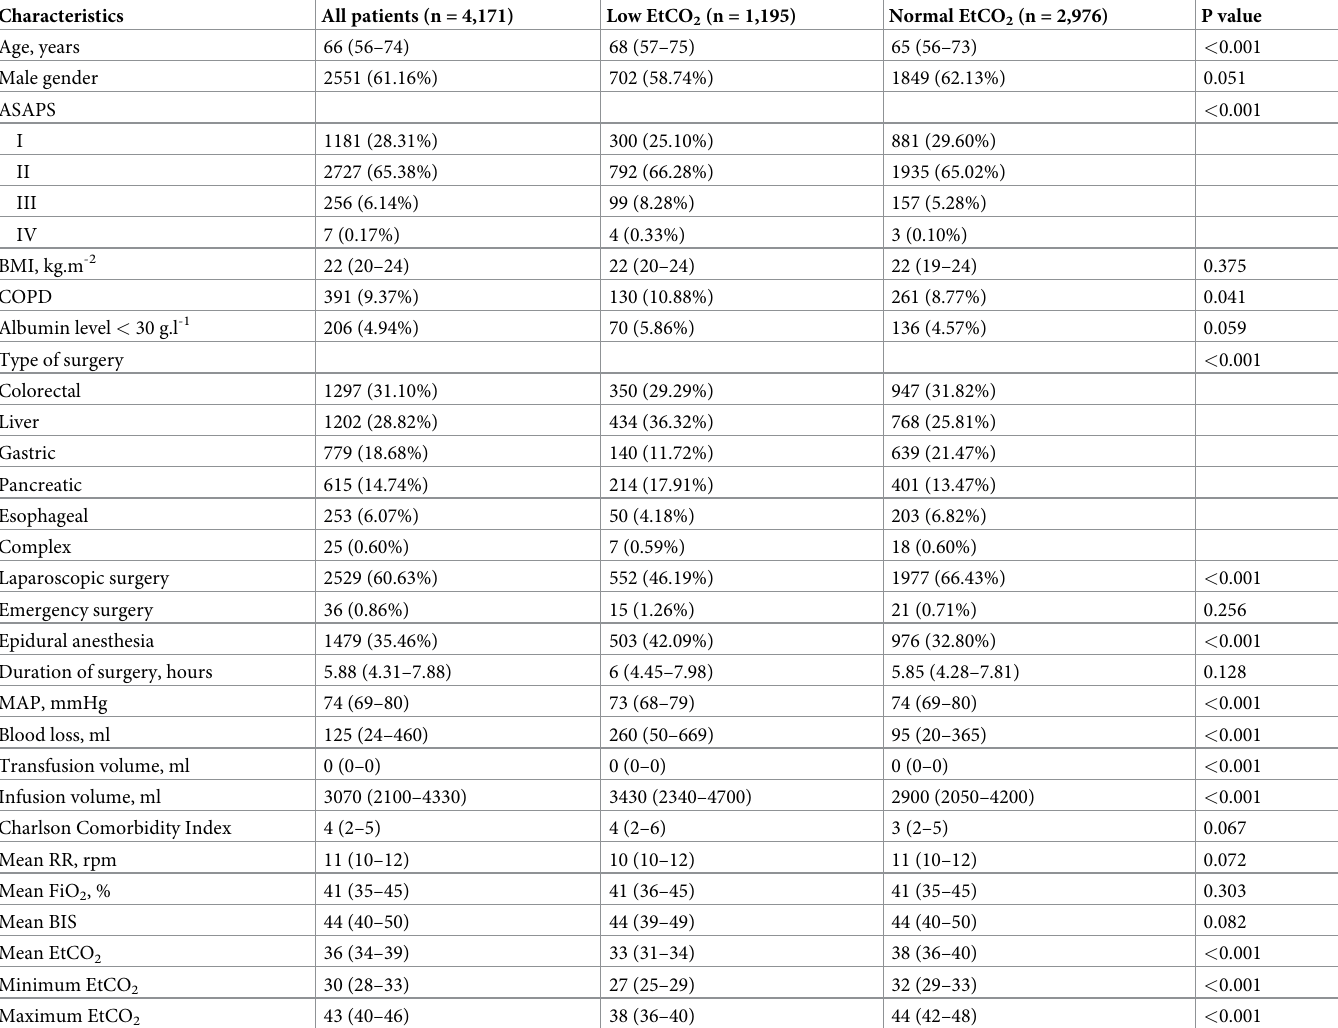
Table 1. Patients’ characteristics (n =